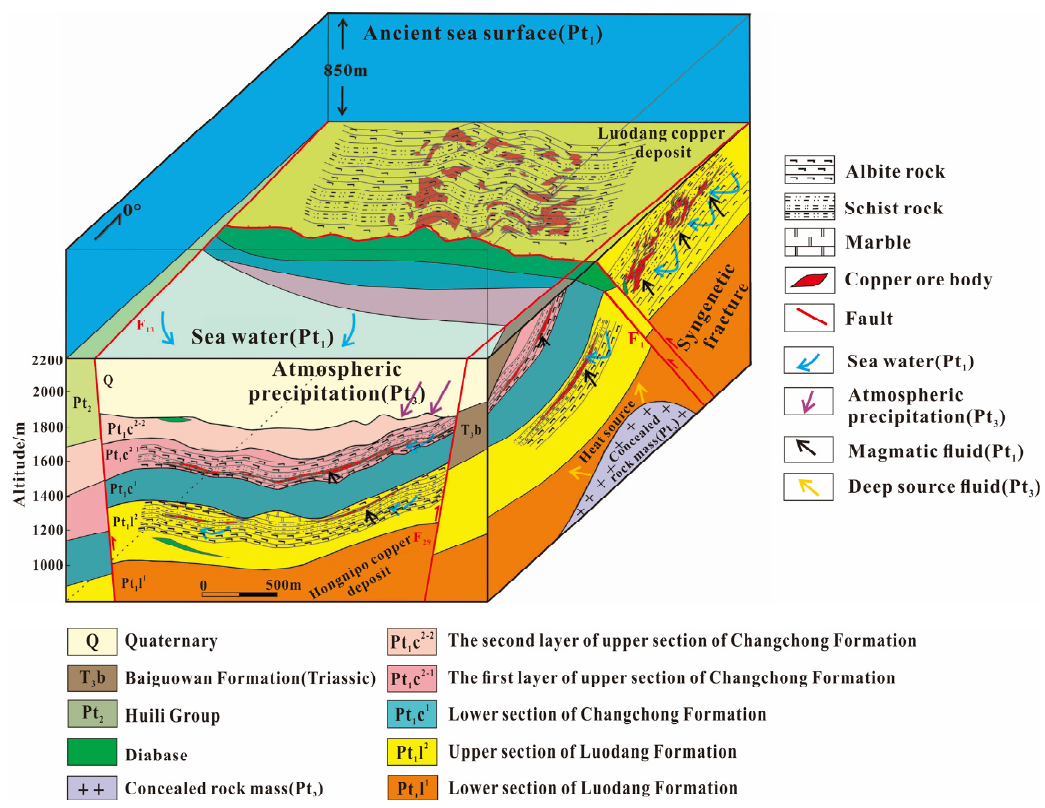
Figure 1. Geological model for prospecting predictions of the Lala copper deposit (modified from [24]).